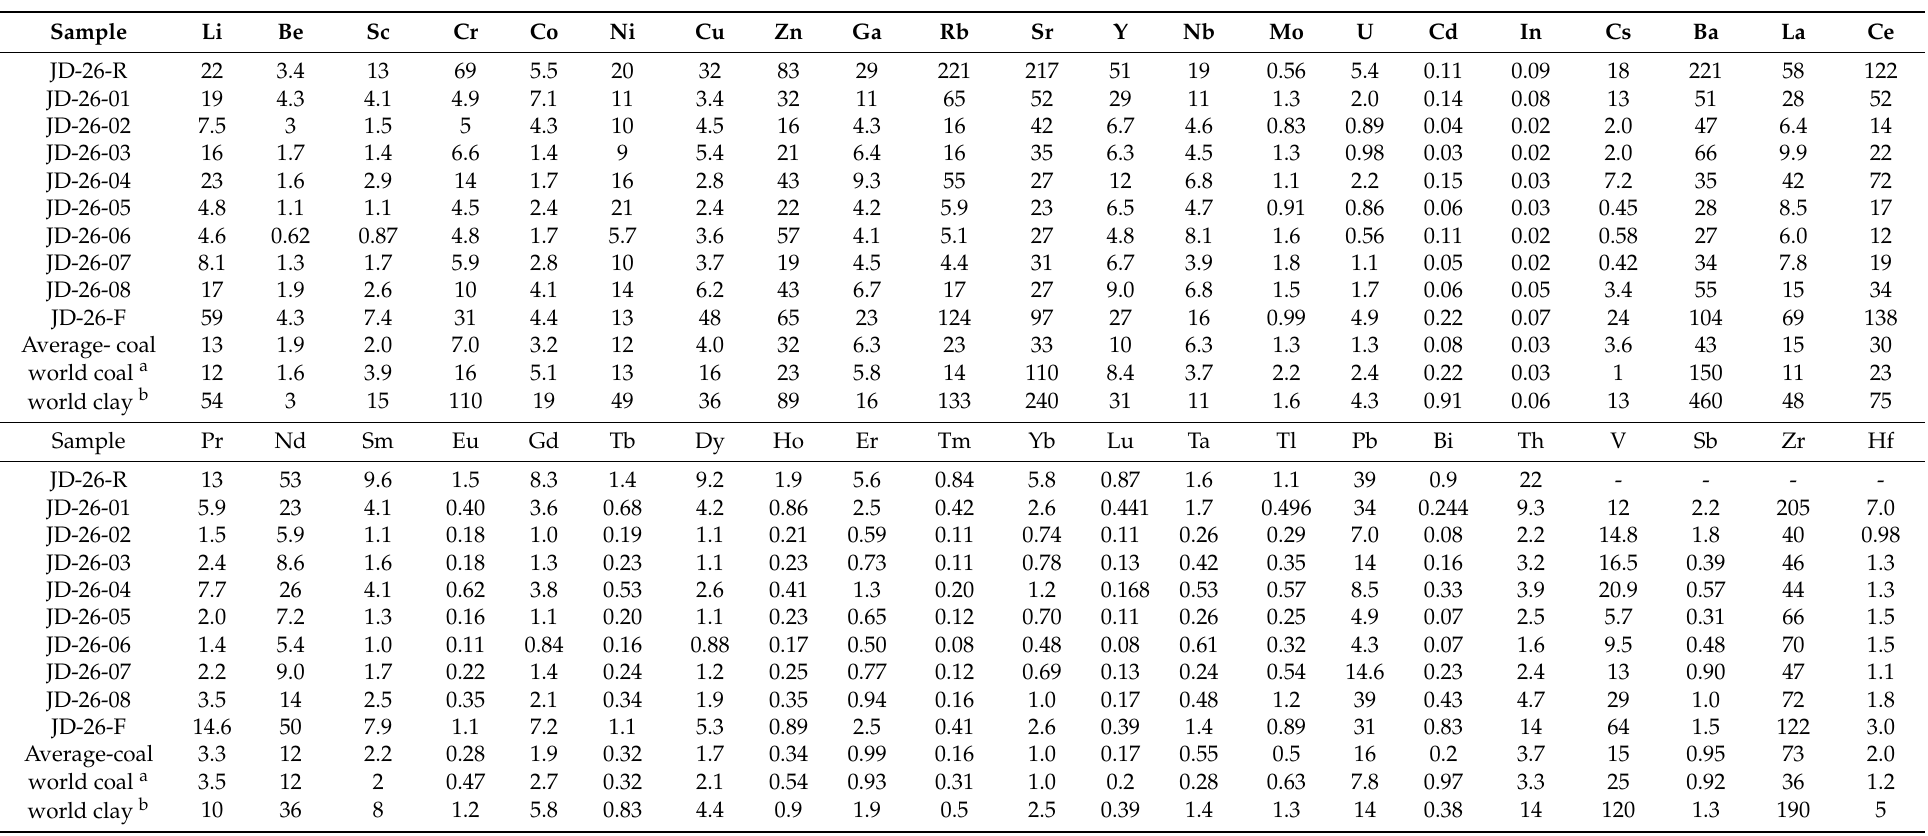
Table 4. Concentrations of trace elements in Junde mine samples, on a whole coal basis ( µ